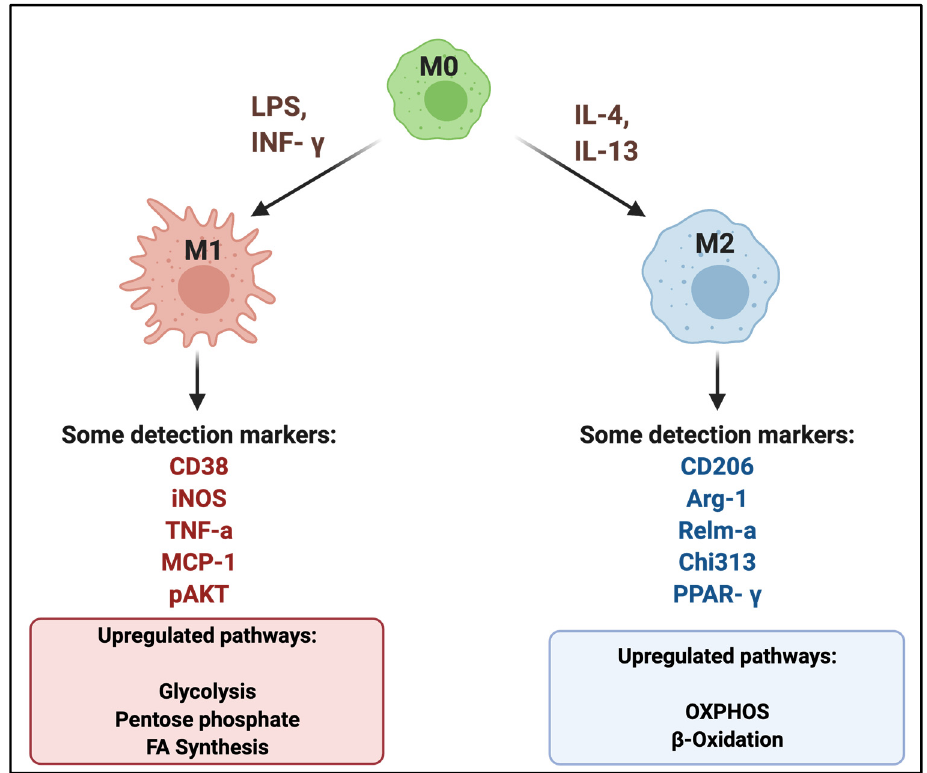
Figure 1. Canonical M1 and M2 polarization of Macs. Under a range of polarization signals, naïve Macs are polarized toward M1-like (LPS, IFN- γ skews) or M2-like (IL-4, IL-13 skews) Macs. There are several surfaces, intracellular or intranuclear markers for the detection of Mac phenotypes. Other than recognition markers, some specific pathways are upregulated or downregulated in M1 and M2 Macs. For example, glycolysis, pentose phosphate pathway, and fatty acid synthesis are upregulated in M1 Macs, while oxidative phosphorylation and β -oxidation pathways are upregulated in M2 Macs.